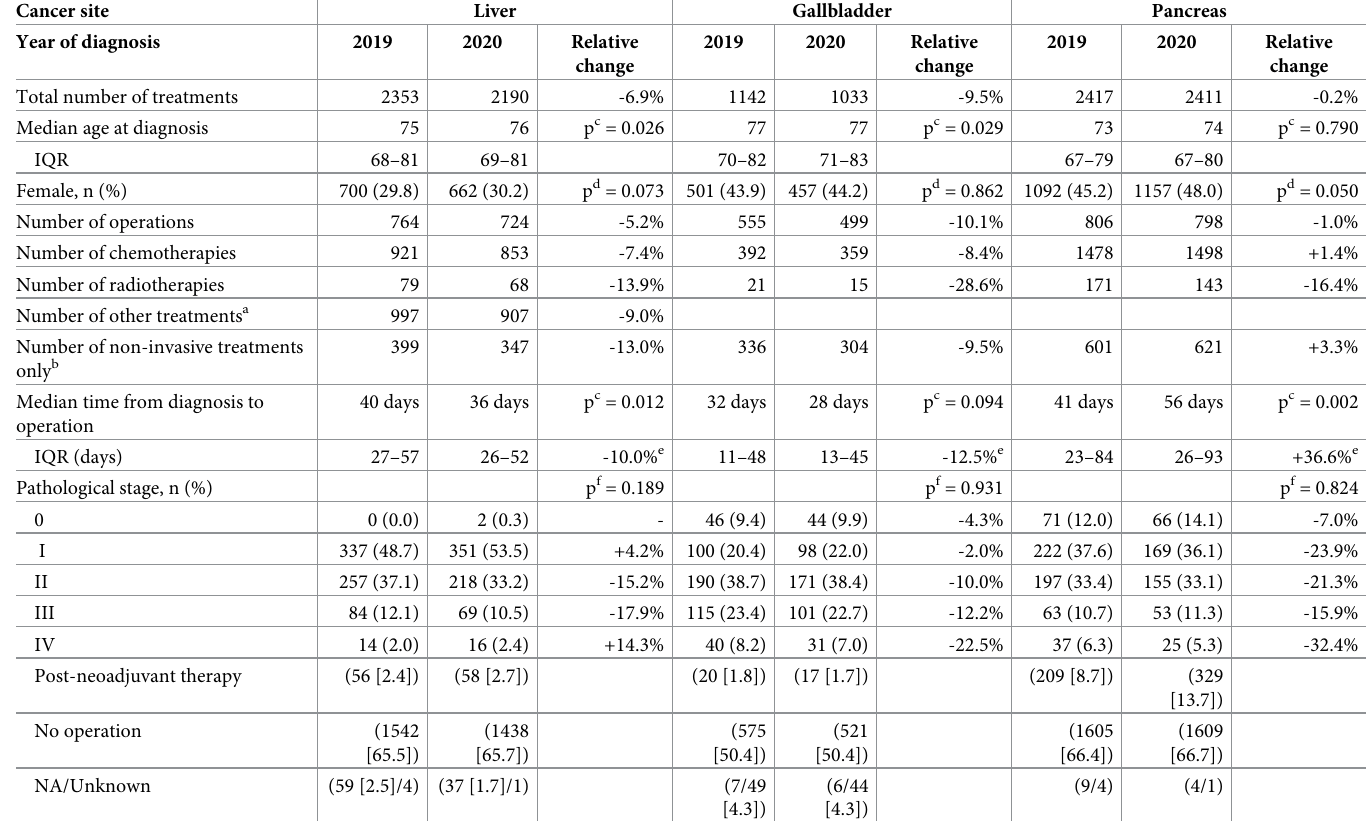
Table 4. Treatment patterns and pathological stage in patients with six digestive cancers in the CanReCO project. Cancer